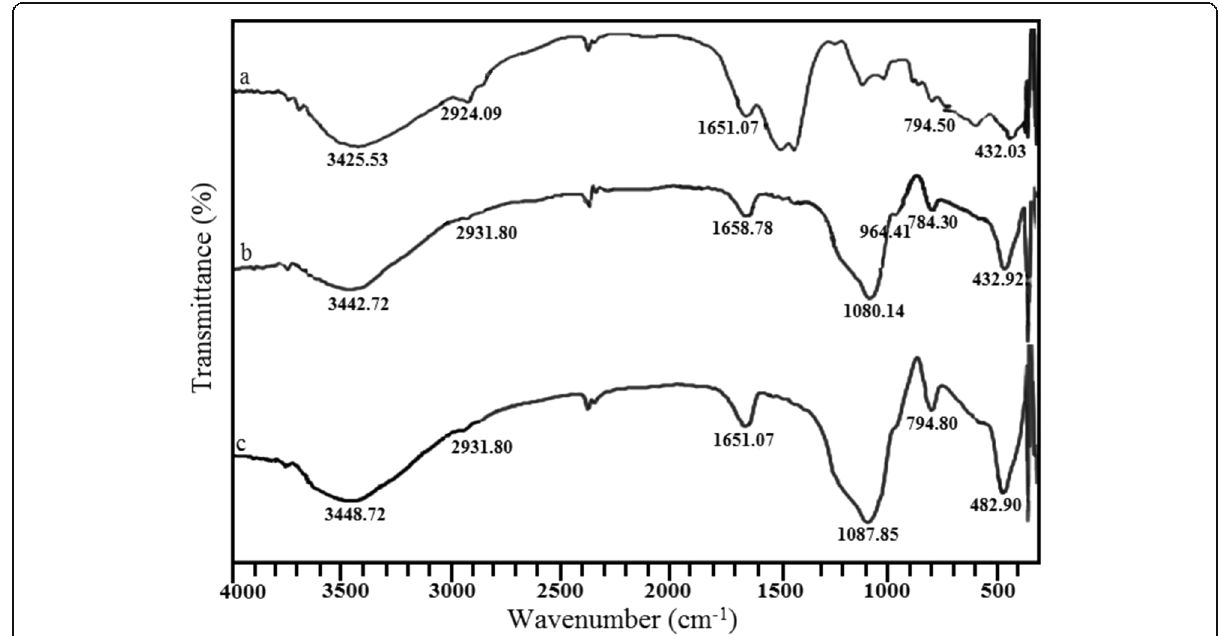
Fig. 1 FTIR spectra of ( a ) Nannochloropsis sp., ( b ) ASN, and ( c )